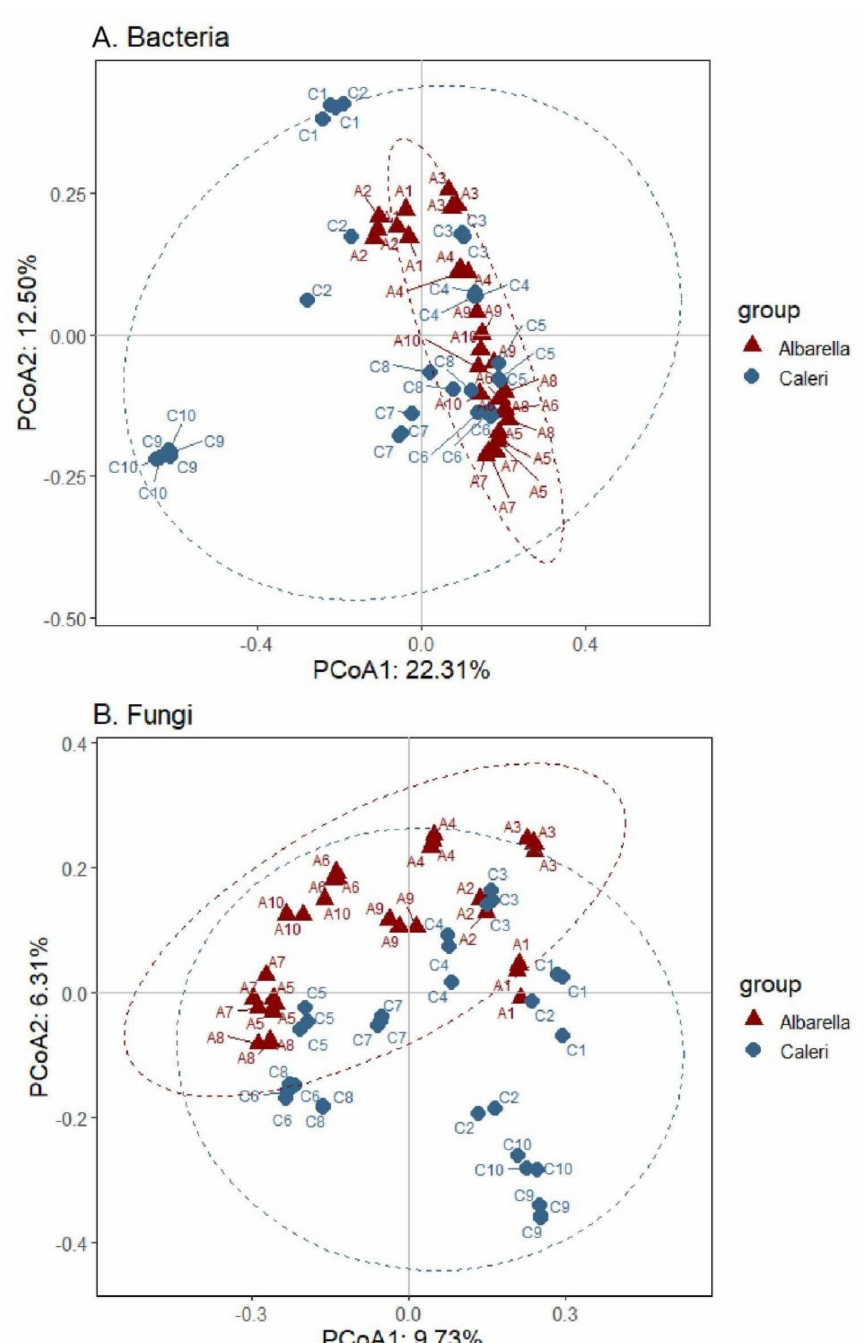
Figure 3. PcoA of microbial community composition across all soil samples in Albarella and